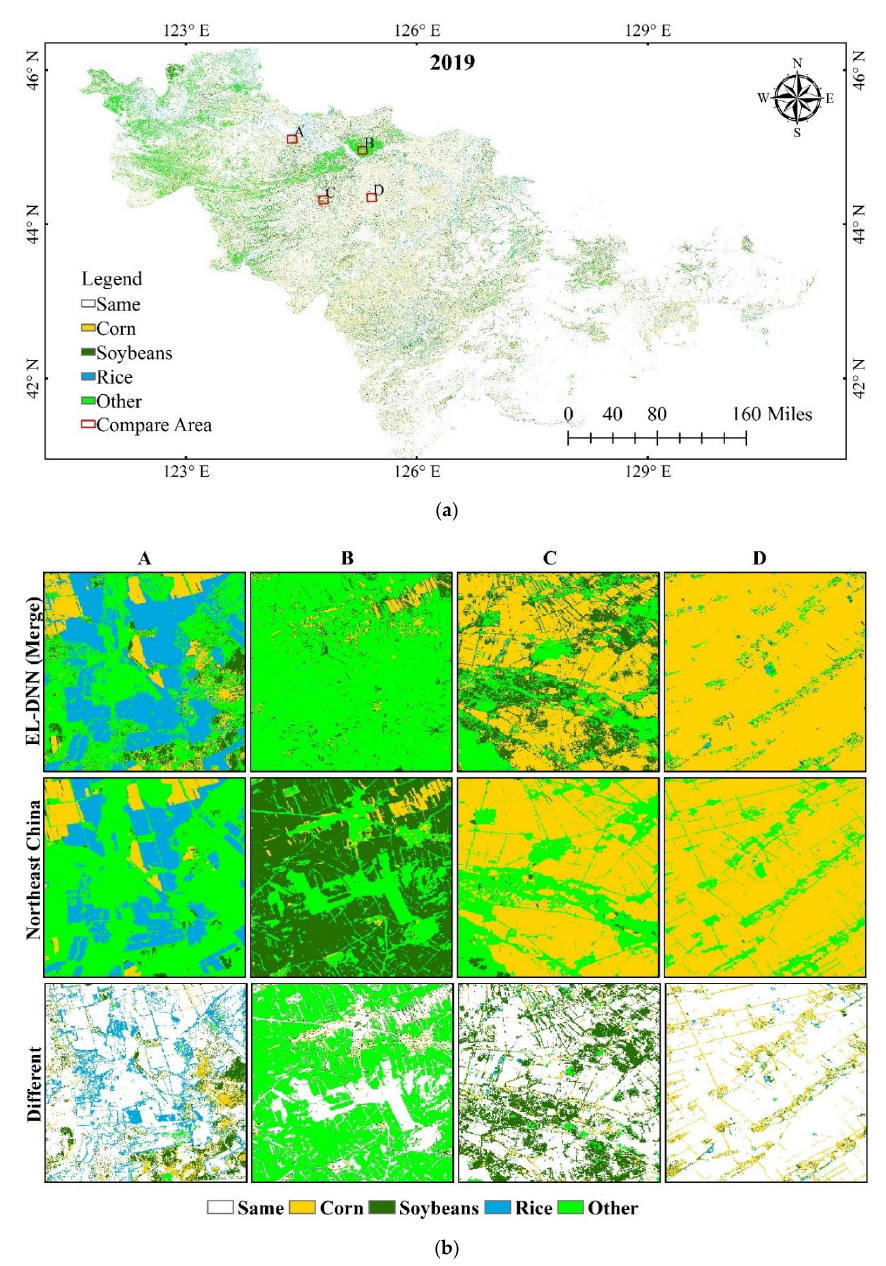
Figure 8. Different pixels of EL-DNN and northeast products. ( a ) Different pixels of the two products in 2019; ( b ) four regions of A, B, C, D in